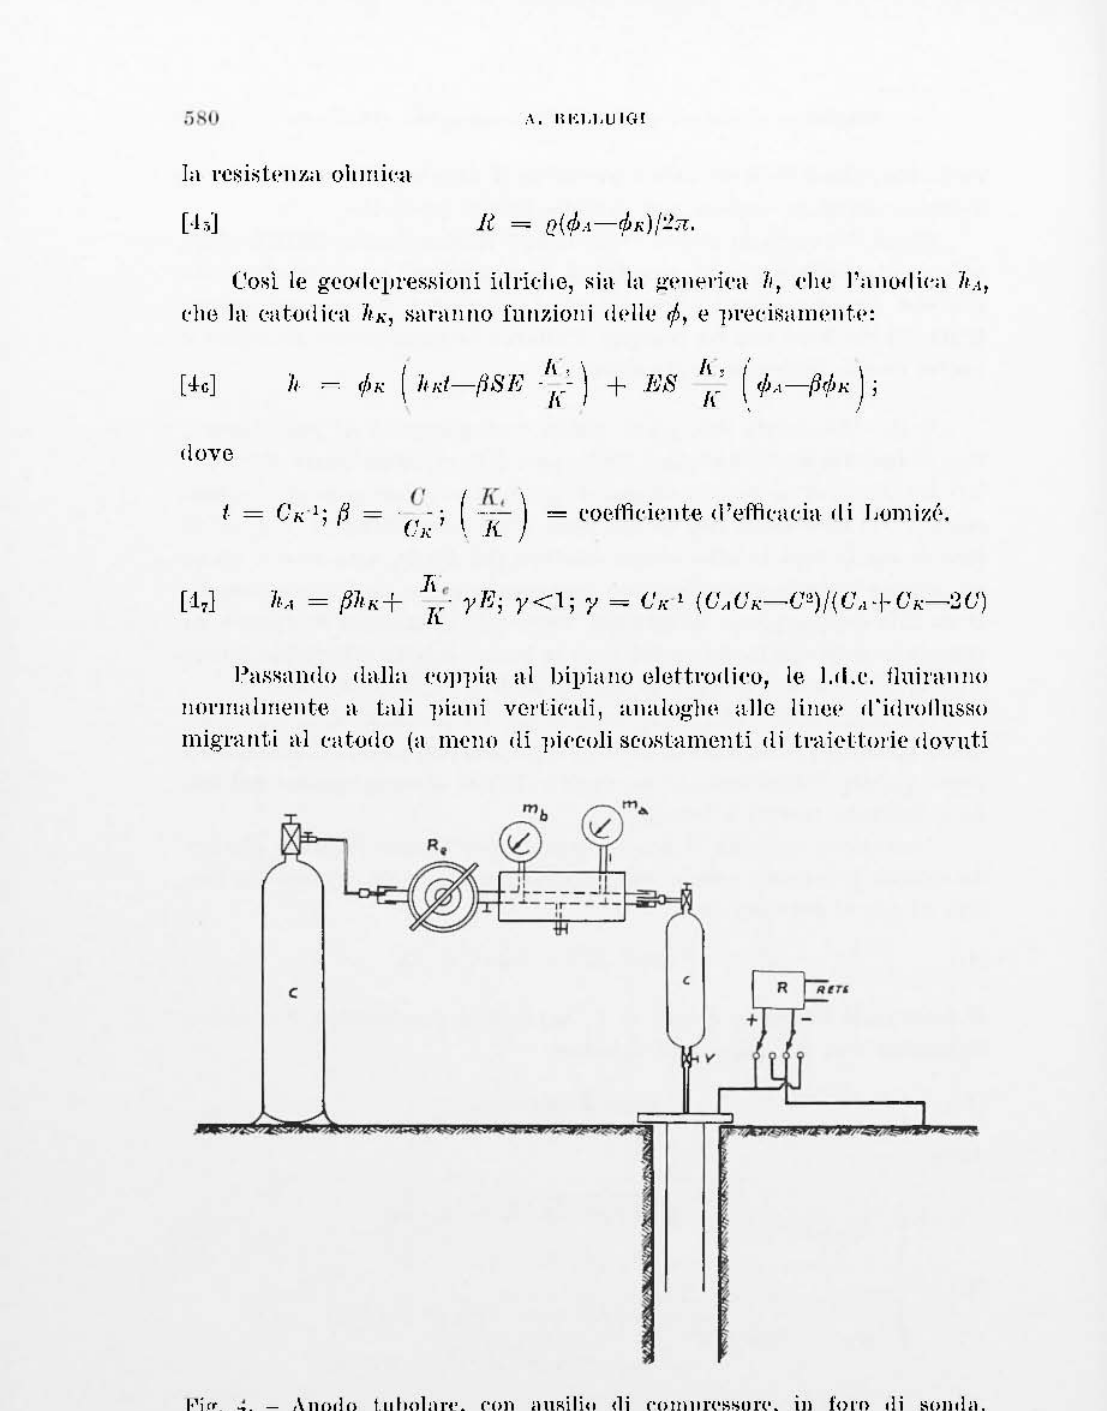
Fig .... - Anoo!o l.ul101nr<:, ('on nnRili" (li ('om!ln'H~()n', in fo['() oli Hono!n, manumetl'i